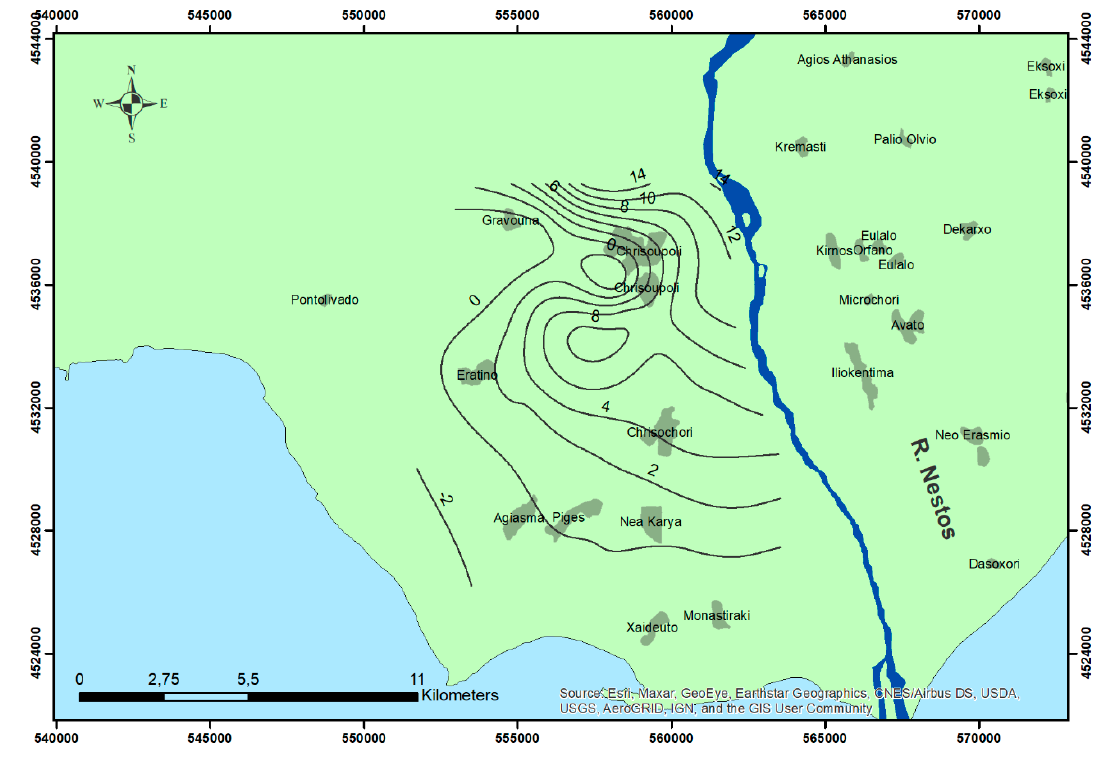
Hydrology 2022 , 9 , x FOR PEER REVIEW Figure 5. Piezometric map of the unconfined aquifer (May 2019). Figure 5. Piezometric map of the unconfined aquifer (May 2019).